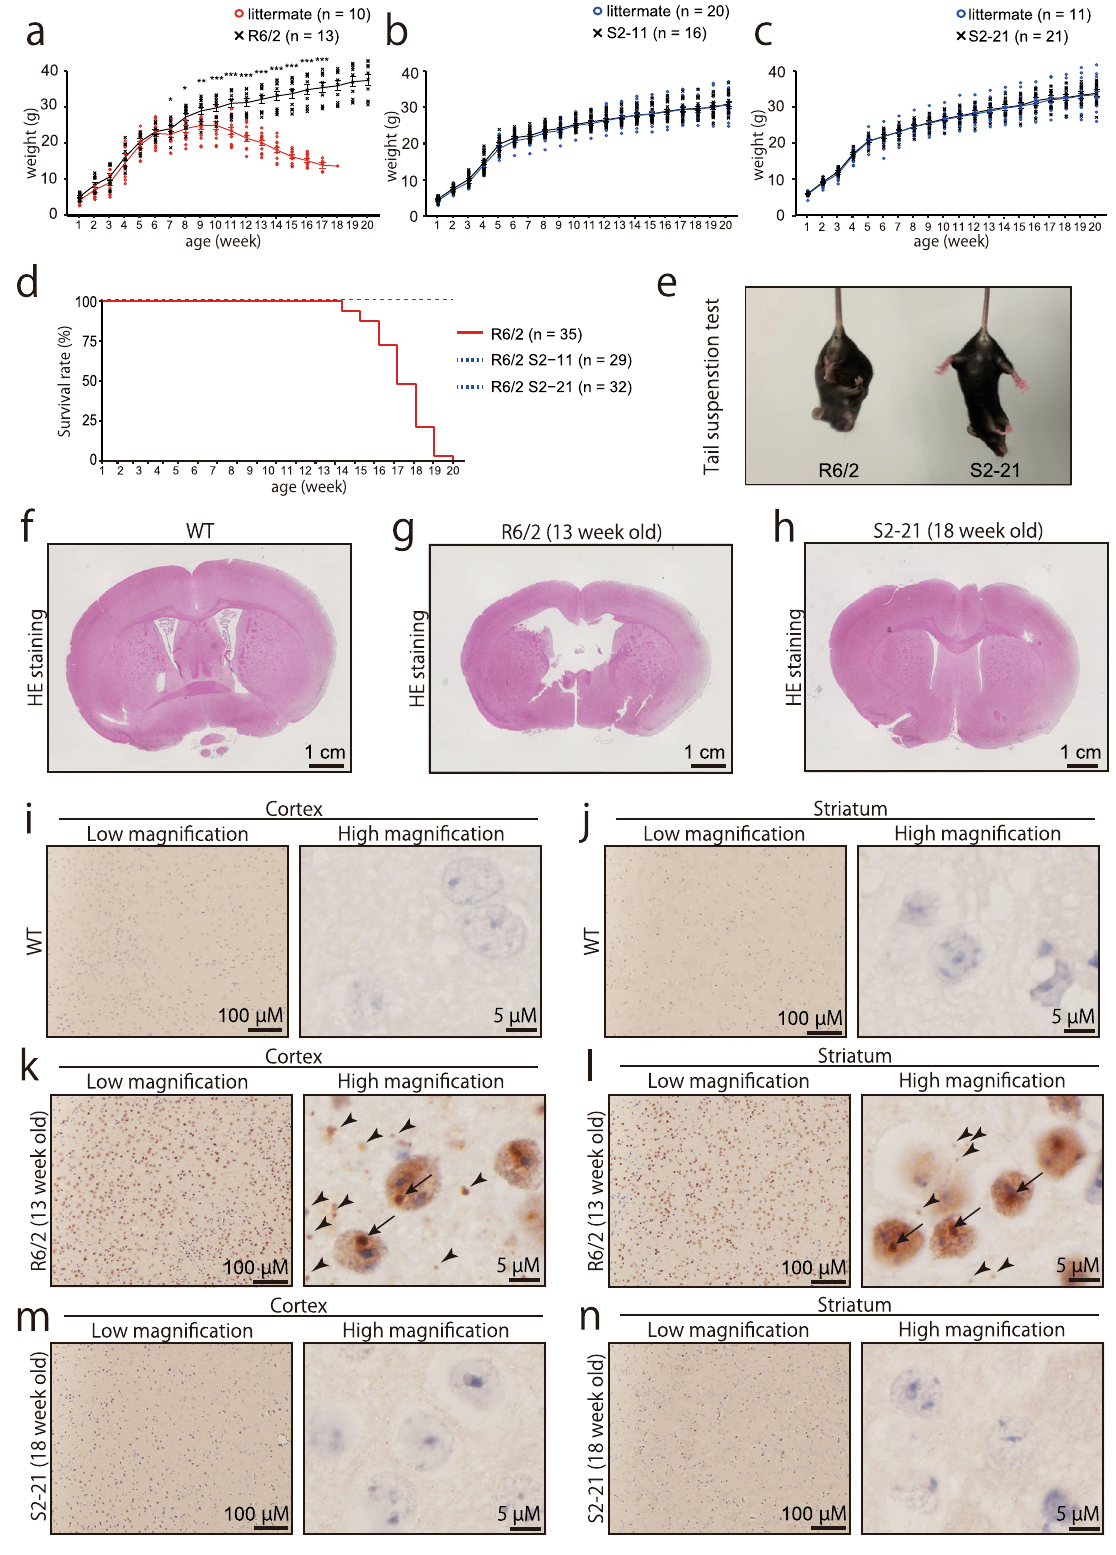
Fig. 6 Phenotypic analysis of R6/2 and isogenic mice produced from repeat-corrected ES cells. a – c Growth curve of R6/2 ( a ) and genome-edited ( b , c ) mice. Male mice were used for plotting and data analysis. Statistical analysis was performed using a two-tailed student ’ s t -test ( p -value = 0.033 [8 week], 0.018 [9 week], 0.004 [10 week], <0.001 [~11 week]). d Survival curve of R6/2 and genome-edited mice. e Tail suspension test of R6/2 (left) and isogenic mice (right). See supplemental video 1. f – h Histological analysis with H&E staining of R6/2 ( g ; 13 week old) and isogenic mice ( h ; 18 week old). Isogenic mice were analyzed at the age when almost all R6/2 mice were dead. i – n Immunohistochemistry with anti-human HTT antibody. Black arrows and arrowheads indicate HTT aggregates inside and outside the nucleus,